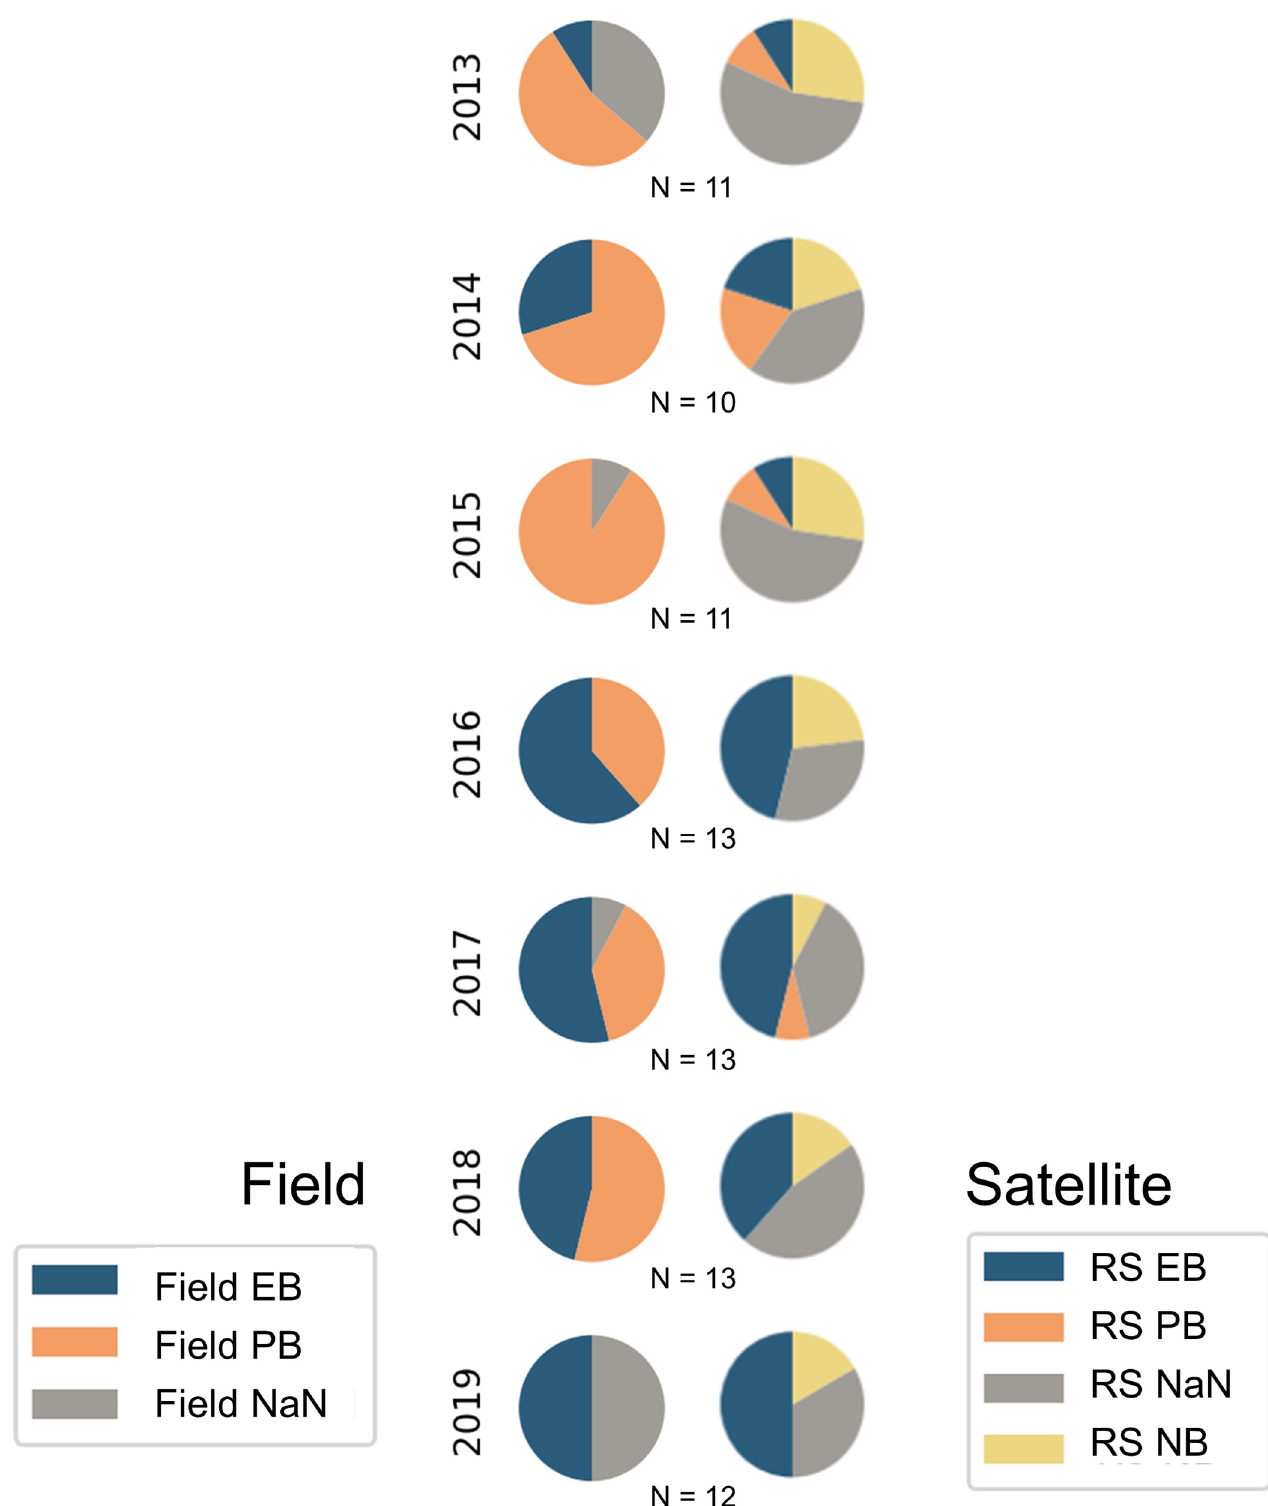
Fig 3. The aggregated counts of bloom stages identified for all of the stations within DBO1 and DBO2 for both the remotely sensed (RS) and cruise- collected (field) pheophytin proportion methods. EB = Early Bloom, PB = Post Bloom, NaN = missing data, NB = No Bloom for observations outside of a bloom cycle. The aggregation was performed using all available years of data (i.e. years that failed the minimum observations criteria for satellite time series are classified here as “RS NaN”). https://doi.org/10.1371/journal.pone.0267586.g003 PLOS ONE | https://doi.org/10.1371/journal.pone.0267586 July 8,